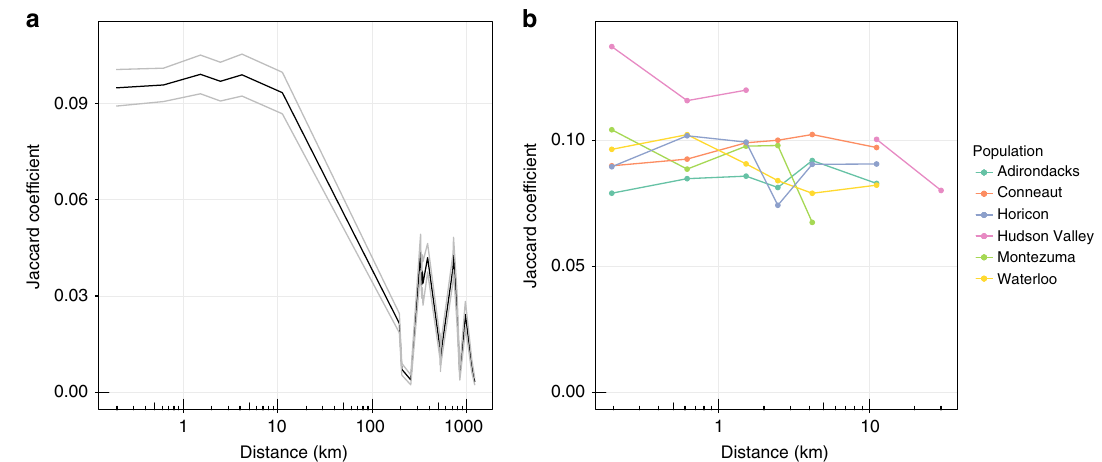
Fig. 3 Geographic variation in syllable sharing. a , b Show the amount of syllable sharing between individuals ’ ( n = 615) repertoires, measured using the Jaccard Index (proportion of shared syllable types out of all types found in a pair of individuals), against the geographical distance between them. a Syllable sharing was high within populations, with no signi fi cant within-population geographic structure, but much lower between populations. b Syllable sharing was similar between the six populations